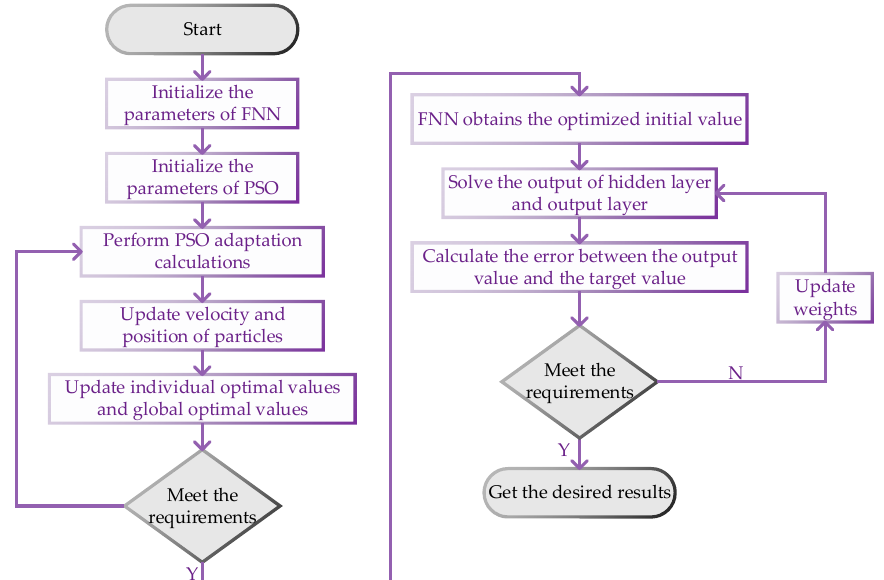
Figure 4. Hybrid algorithm optimization flow chart.